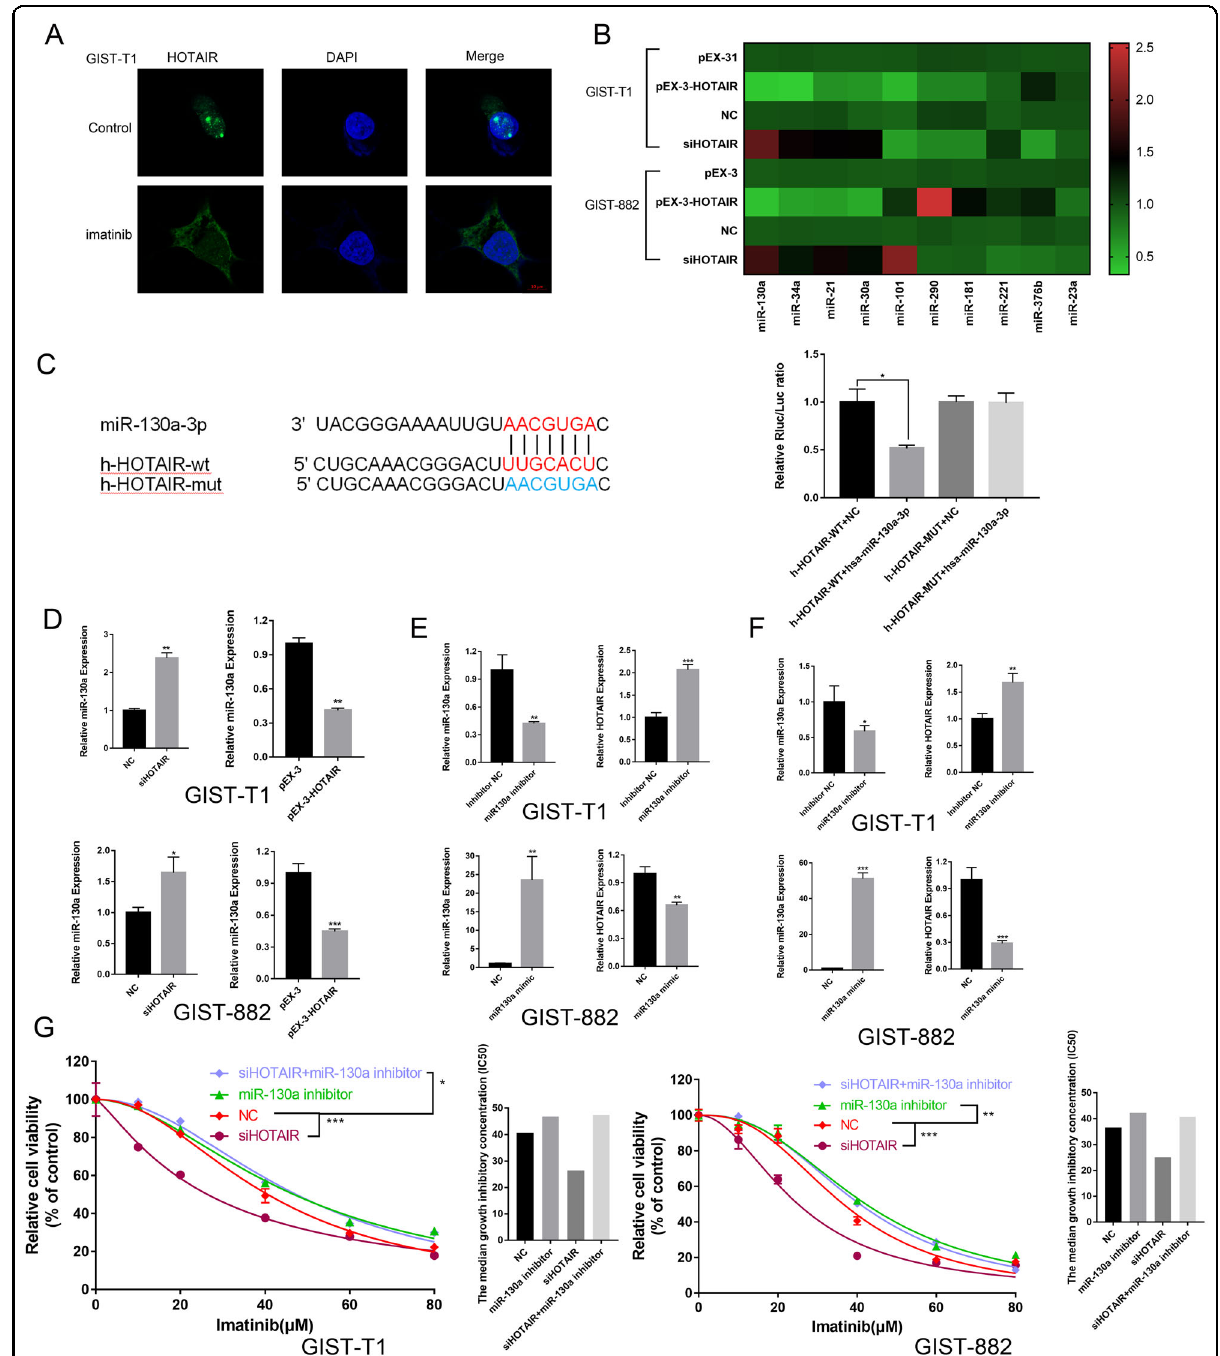
Fig. 3 HOTAIR expression correlates negatively with miRNA-130a levels in GISTs. A The distribution of HOTAIR in GIST-T1. B Heat map of differentially expressed miRNAs after regulating the expression of HOTAIR. C Binding sites of HOTAIR in miRNA-130a-3p predicted using TargetScan and the results of Luciferase reporter gene assays in HEK293T cells. * P < 0.05 vs. h-HOTAIR-WT + NC. D Cells transfected with pEX-3-HOTAIR showed markedly decreased levels of miRNA-130a and siHOTAIR upregulated the levels of miRNA-130a in GIST cells. * P < 0.05; ** P < 0.01; *** P < 0.001 vs. NC or pEX-3. E The ef fi ciency of transfection of the miRNA-130a mimic or miRNA-130a inhibitor. ** P < 0.01; *** P < 0.001 vs. NC or inhibitor NC. F The miRNA-130a mimic notably decreased the levels of HOTAIR and the miRNA-130a inhibitor increased the mRNA levels of HOTAIR in GIST cells. * P < 0.05; ** P < 0.01; *** P < 0.001 vs. NC or inhibitor NC. G CCK-8 assays were used after co-transfection GIST cells with the miR-130a inhibitor and siHOTAIR. * P < 0.05; ** P < 0.01; *** P < 0.001 vs.